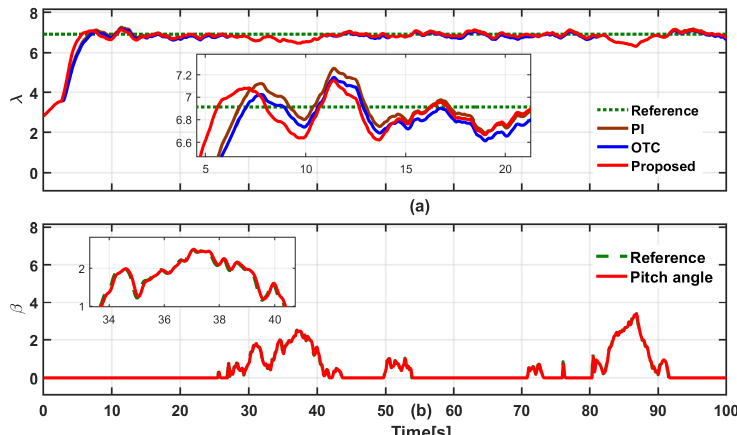
Figure 12. Results for the case II with wind speed of region II and III: ( a ) Tip speed ratio λ . ( b ) Pitch angle β